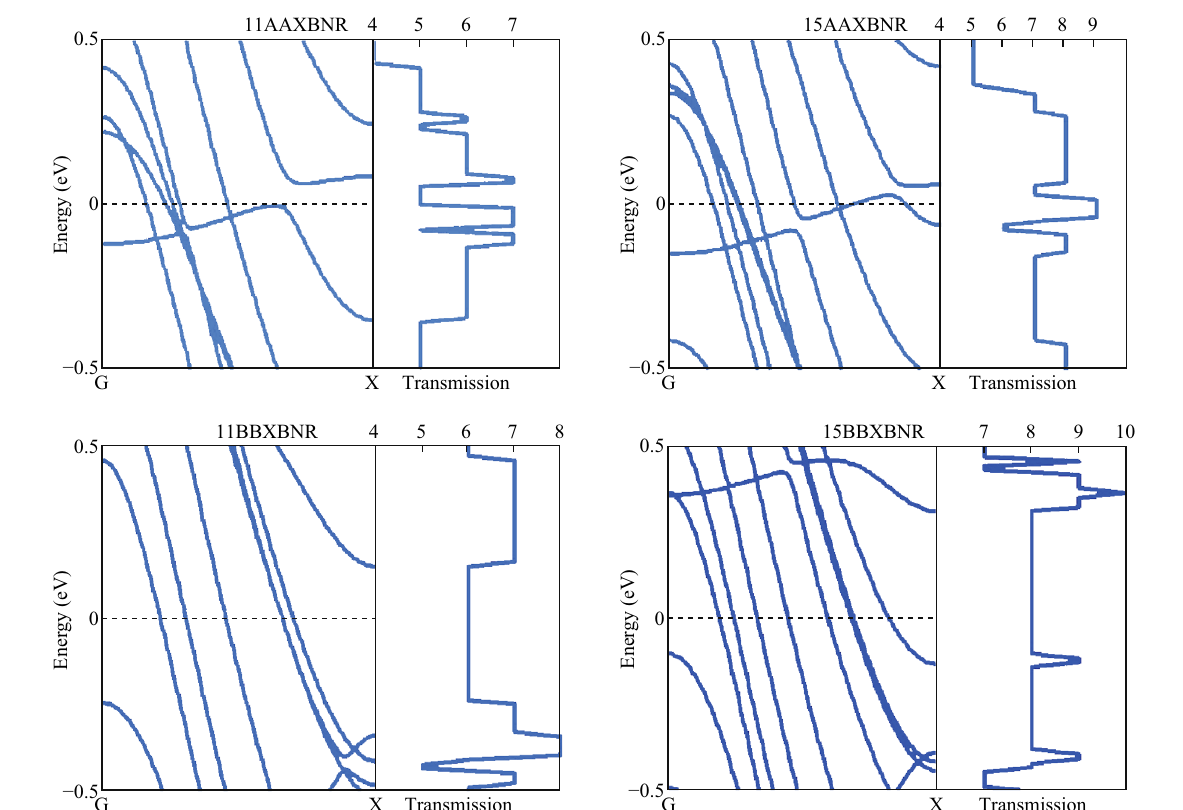
Fig. 5 Band structure and the transmission channel of 11AAXBNR , 15AAXBNR , 11BBXBNR , and